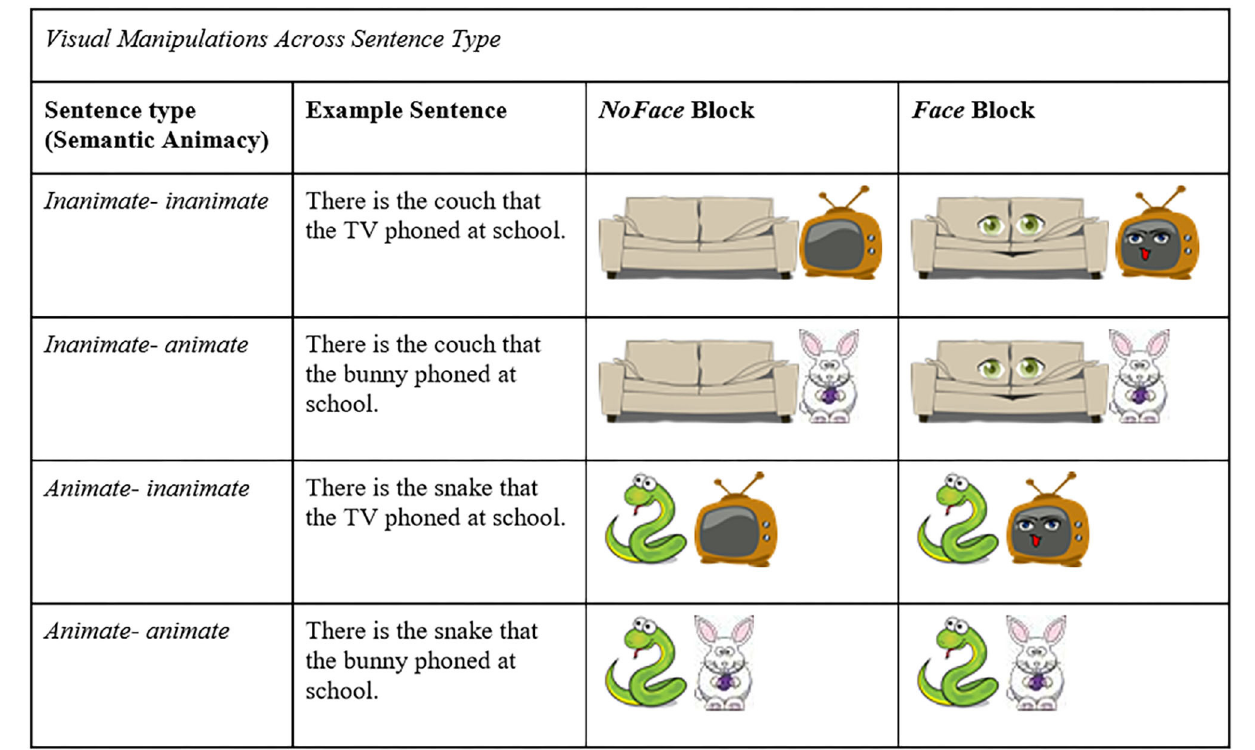
FIGURE 1 | Example Visual Manipulations. Example visual manipulations of test item “There is the couch that the TV phoned at school. He was excited to go to the movie that night.” for each condition and sentence type.